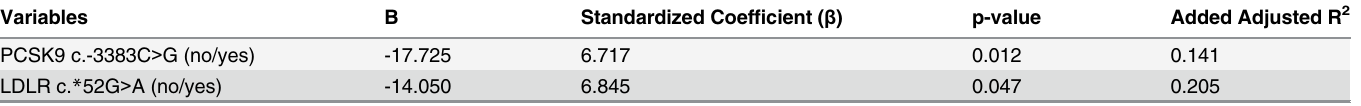
Table 2. Genetic variables independently associated with LDLc response to Armpolipid Plus 1 by linear